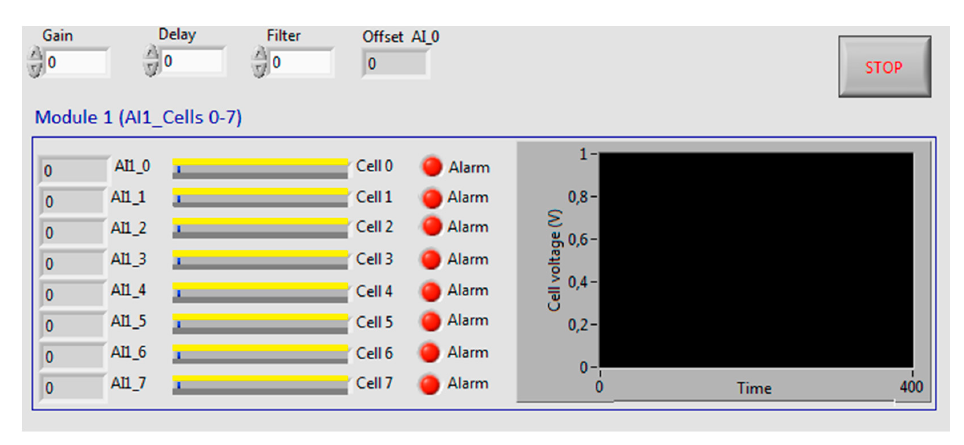
Figure 4. GUI for PEFC voltage tracking.